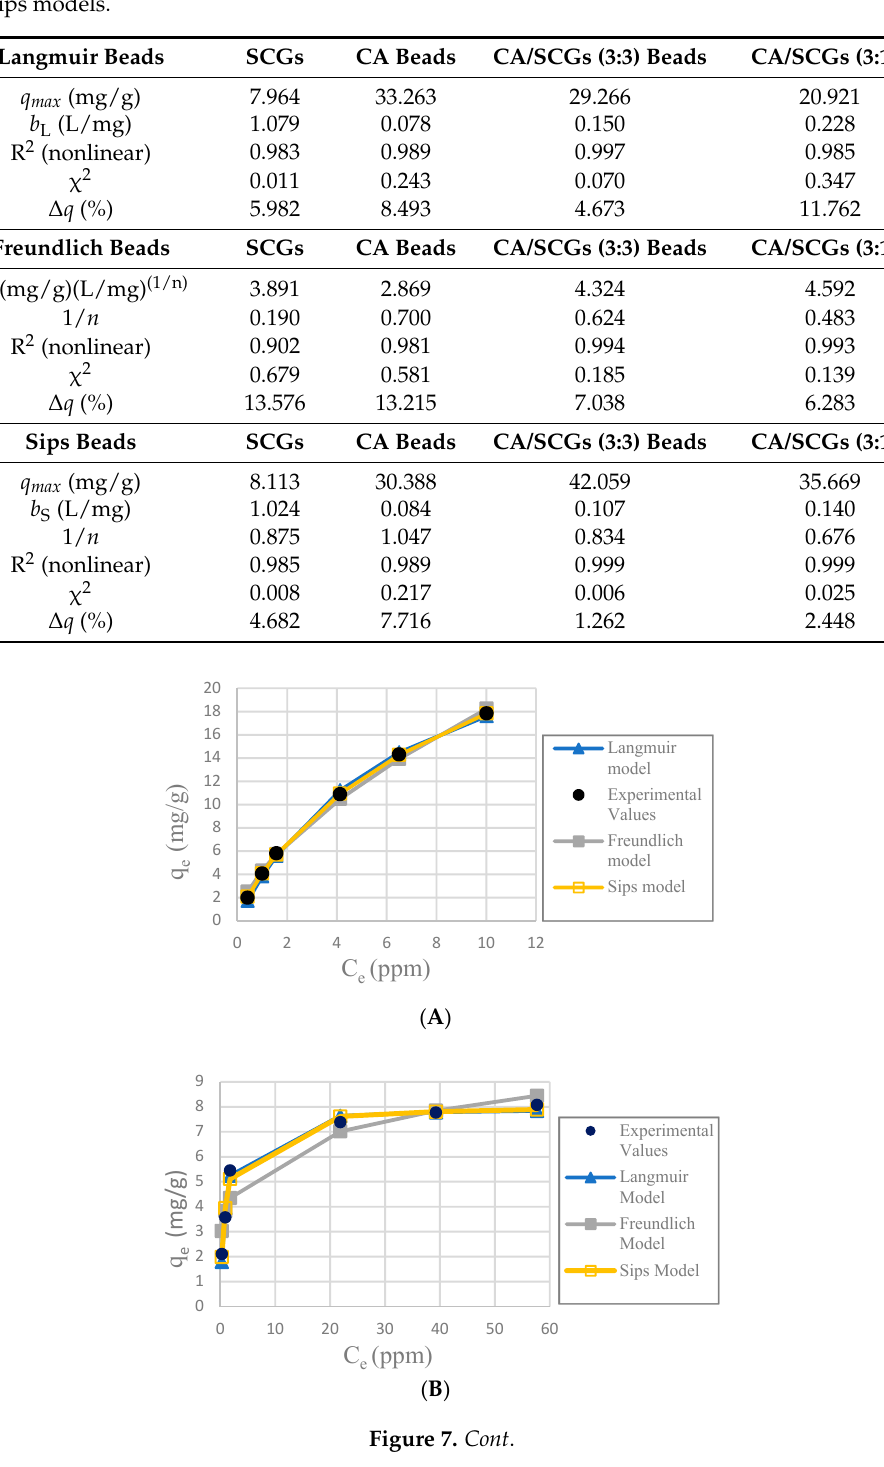
Table 1. Adsorption isotherm constants and statistical comparison values for Langmuir, Freundlich and Sips models.